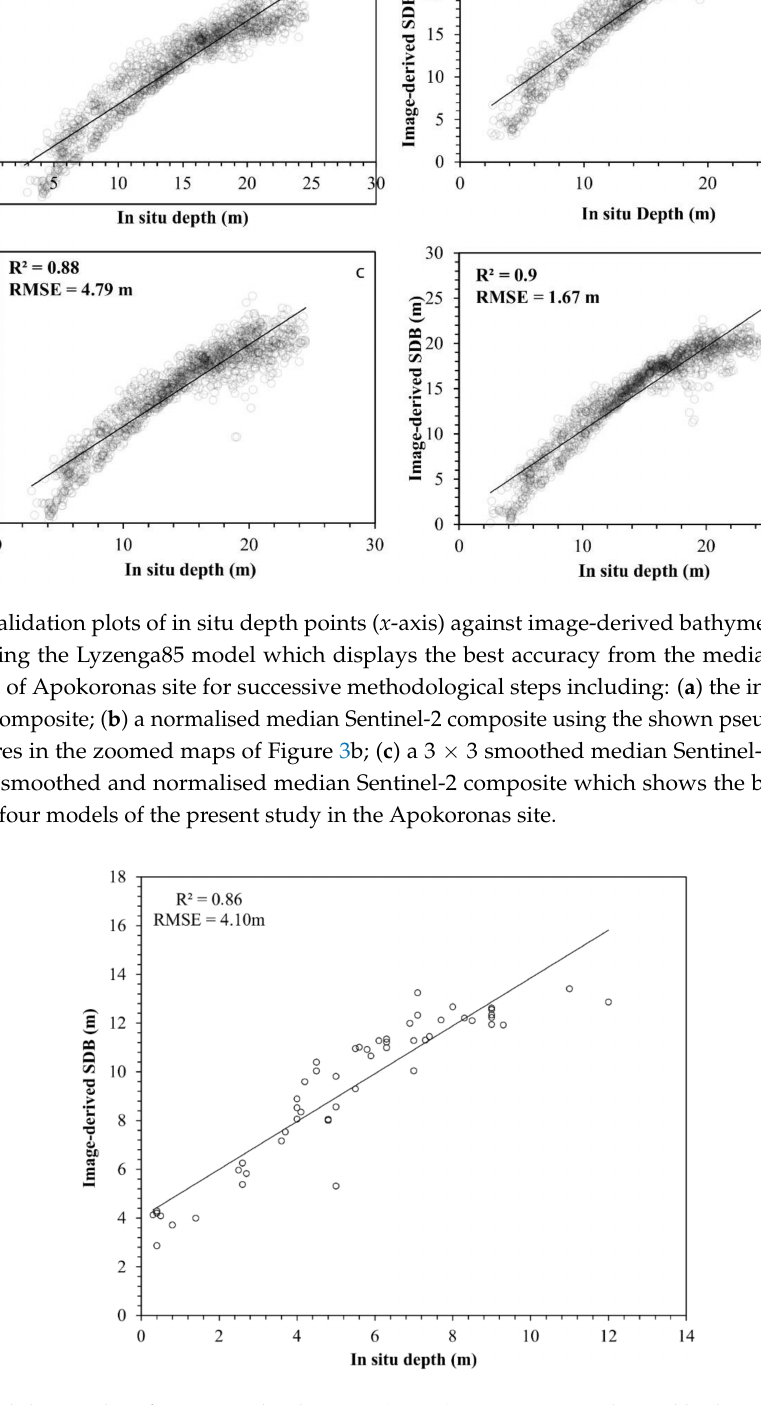
Figure 6. Validation plot of 53 in situ depth points ( x -axis) against image-derived bathymetries ( y -axis) employing the Lyzenga85 model on the 3 × 3 smoothed and normalised median Sentinel-2 composite of Thermaikos